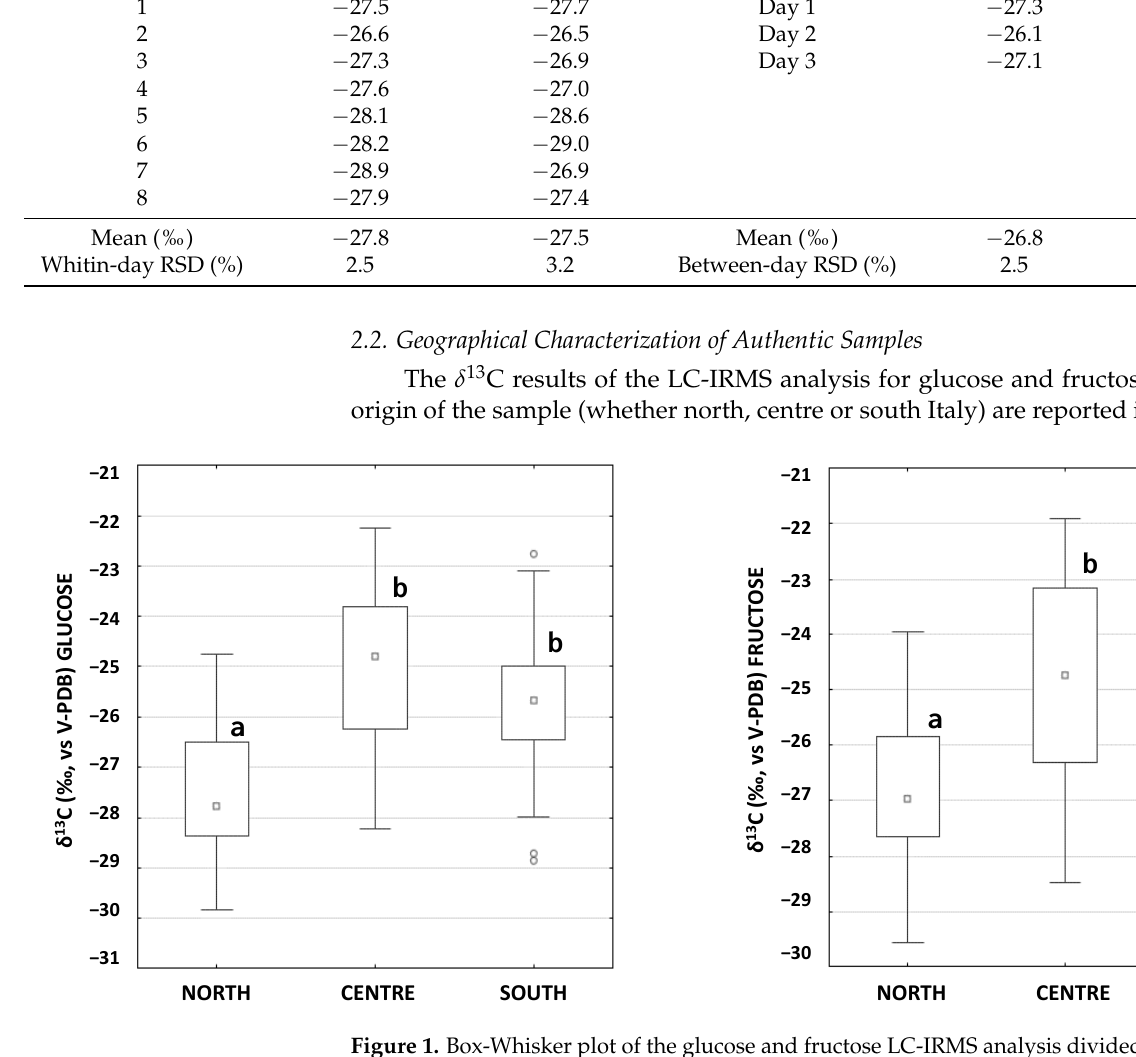
Figure 1. Box-Whisker plot of the glucose and fructose LC-IRMS analysis divided by the origin of the sample (north, centre or south Italy). Different letters identify statistically different groups according to the ANOVA ( p < 0.01).